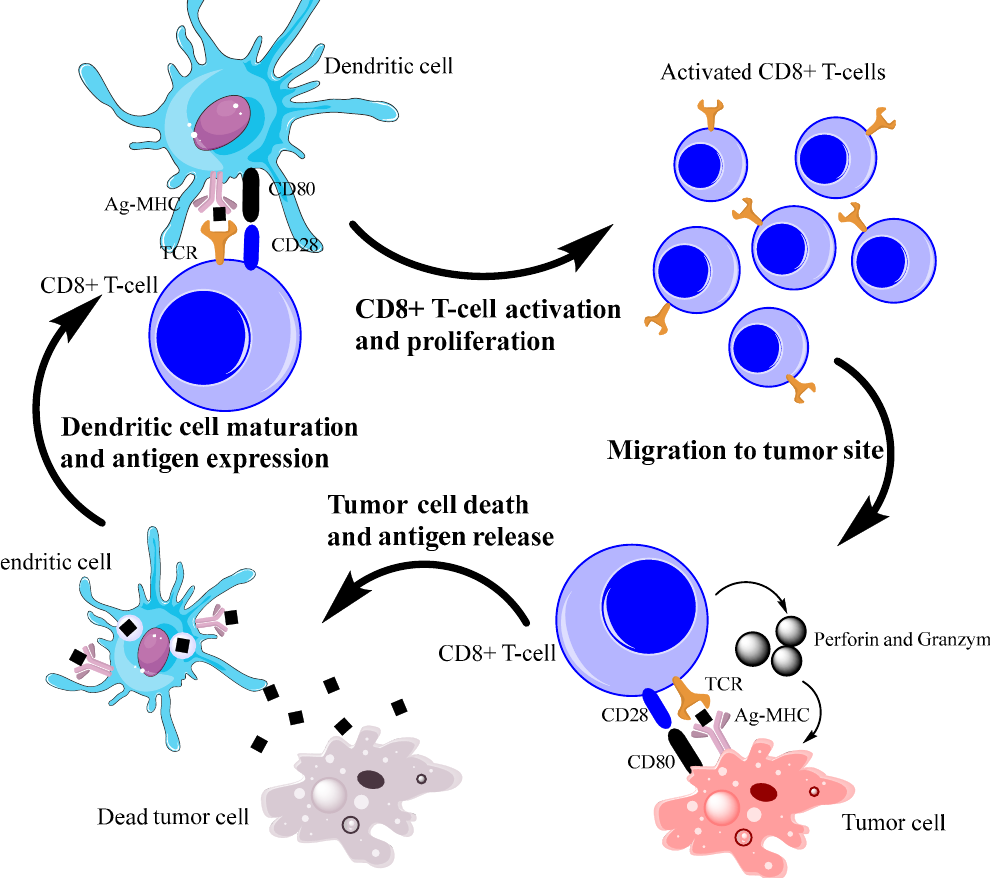
Figure 1. Simplified depiction of CD8 + T-cell antitumor immunity. CD8 + T cells are sensitized by dendritic cells via interactions between TCRs and antigen-bearing MHC I receptors, causing activation and proliferation of the CD8 + T cells. Then, CD8 + T cells migrate from the lymph node to the tumor site, targeting the antigen-bearing tumor cells for apoptosis via perforin and granzymes. The tumor cell releases antigens, which are captured by dendritic cells, which mature in the lymph nodes and cause further potentiation of T cells. Ag = antigen; MHC = major histocompatibility complex; TCR = T-cell antigen receptor.